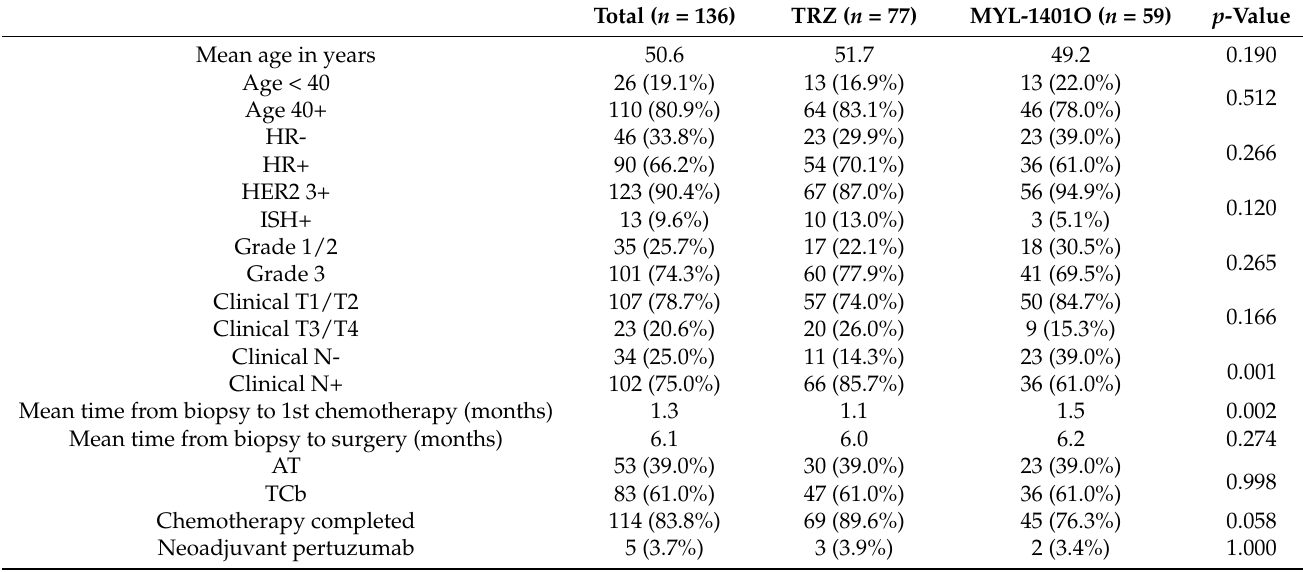
Table 3. Cohort characteristics.